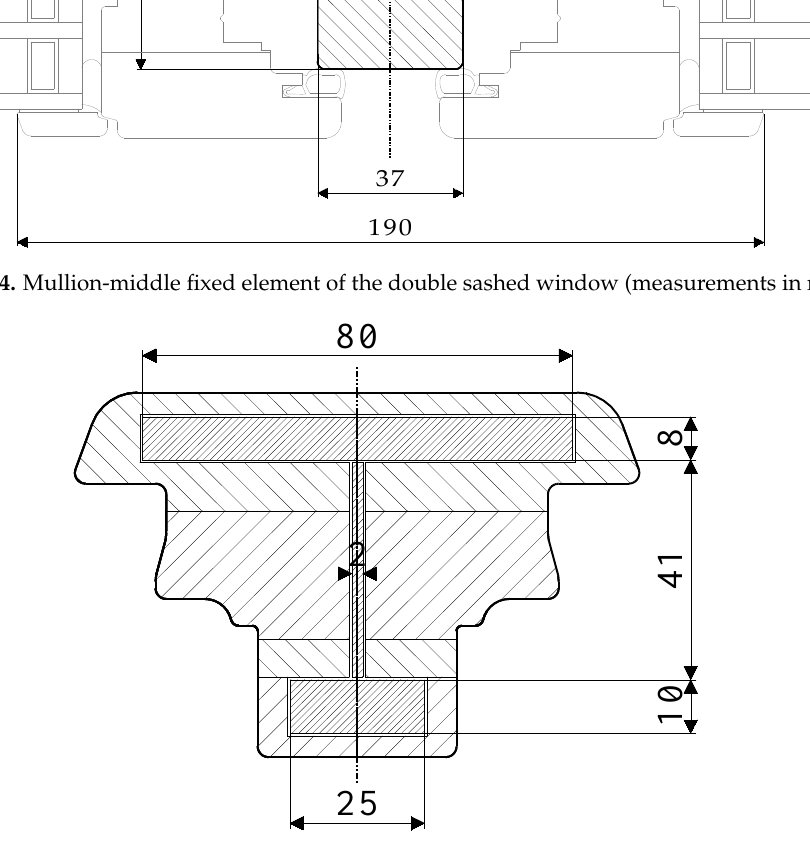
Figure 15. Example of window profile with horizontally and vertically positioned reinforcements (measurements in mm).